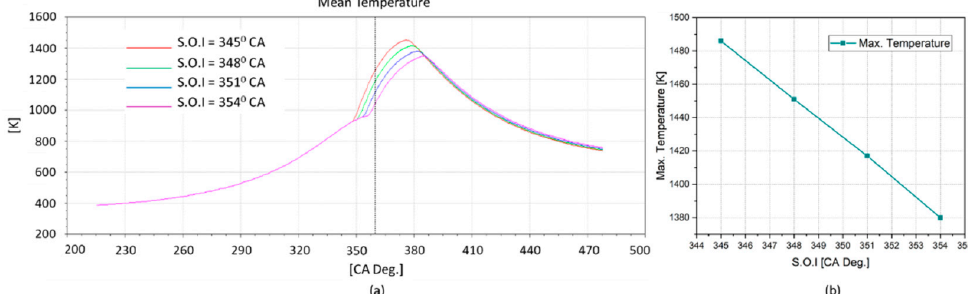
Figure 21. In-cylinder temperature diagrams ( a ) and maximum temperature ( b ) according to the change of the S.O.I angle in the diesel.